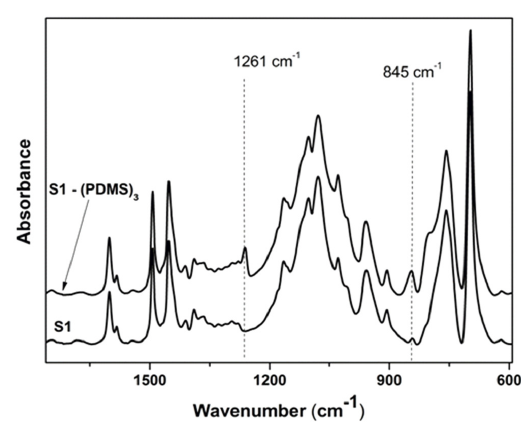
Fig 3. Infrared spectrum of the macrosilane precursor S1 and the corresponding S1- (PDMS) 3